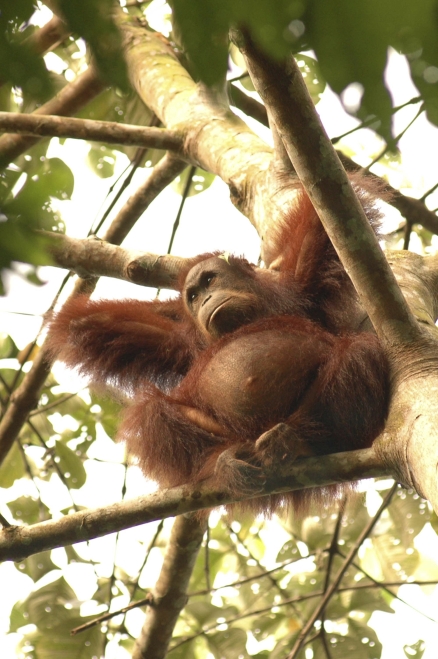
At eight years old, orang-utans like Etin, who lives in the KOCP intensive study site in the Lower Kinabatangan Sanctuary, start wandering alone in the forest to find a new territory.(Image: Jamil Sinyor)